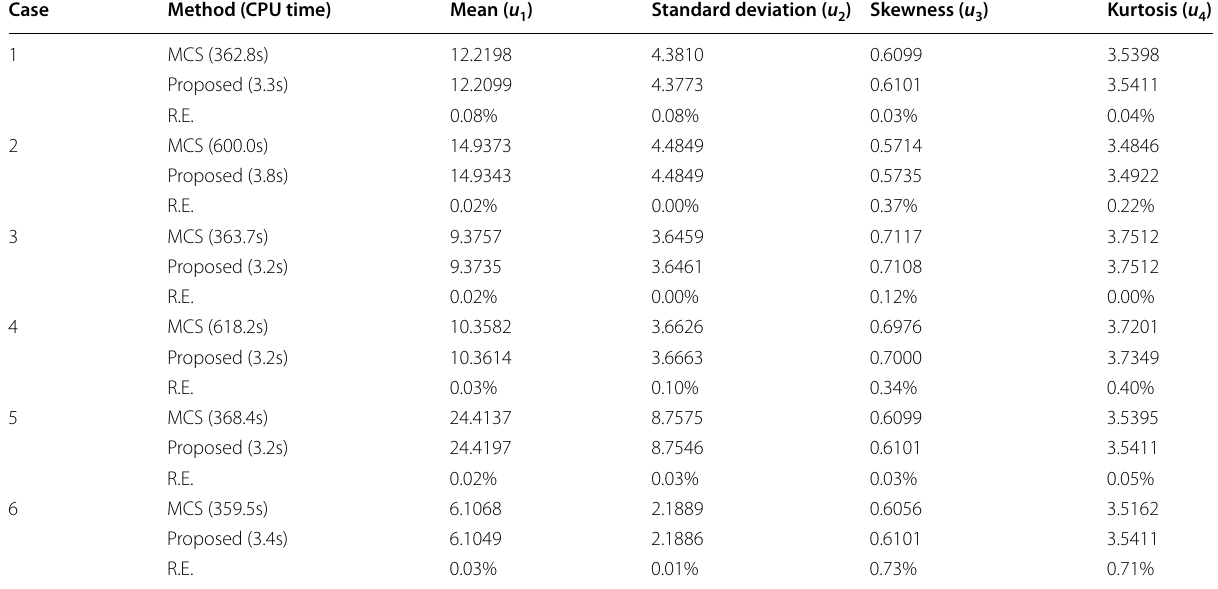
Table 1 Relative errors of first-four central moments